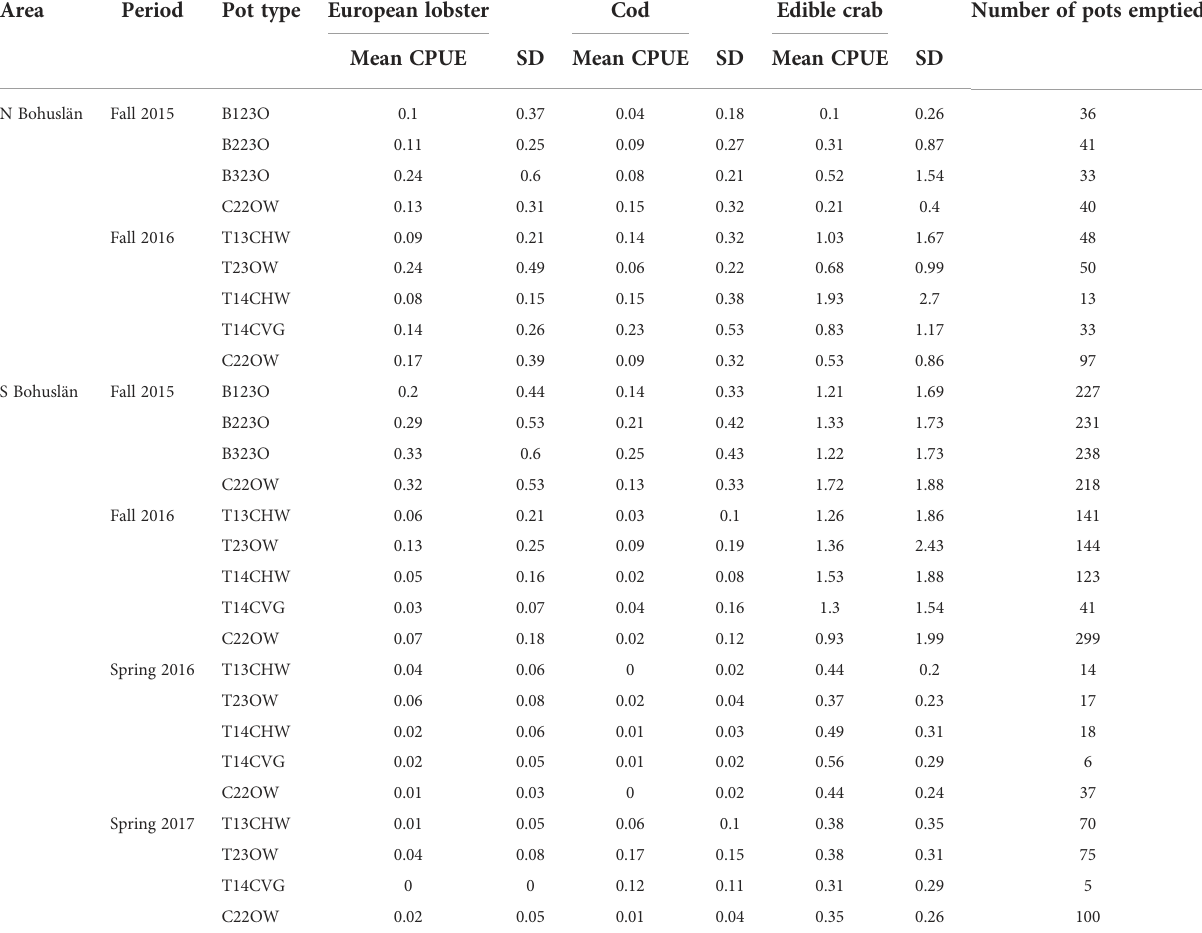
TABLE 2 CPUE of species caught per pot type for each area and period. Area Period Pot type European lobster Cod Edible crab Number of pots emptied